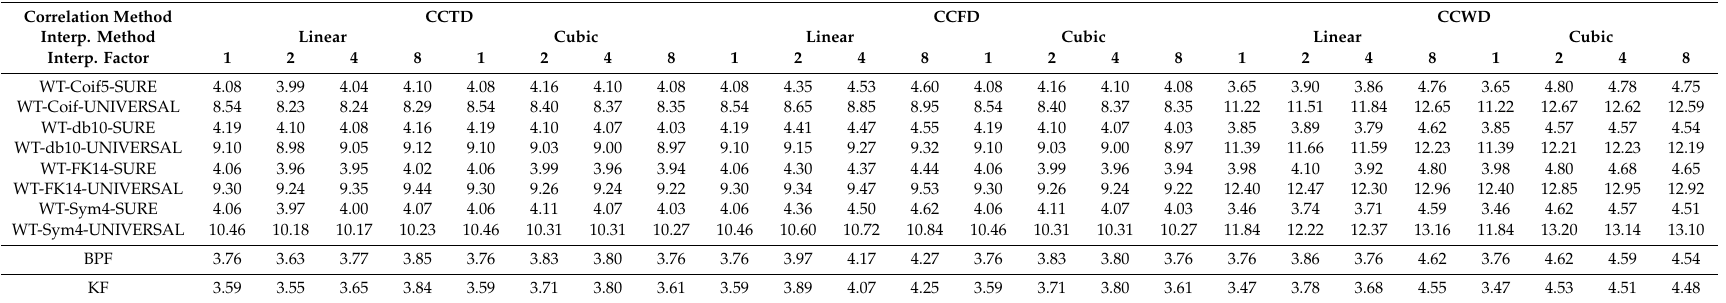
Table 2. Comparison (Euclidean distance) of lightning mapping estimation consisting of di ff erent filtering and cross-correlation approaches. Correlation